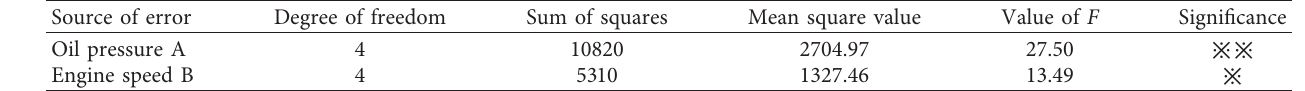
Table 3: ANOVA with all-factors test for speed drop.